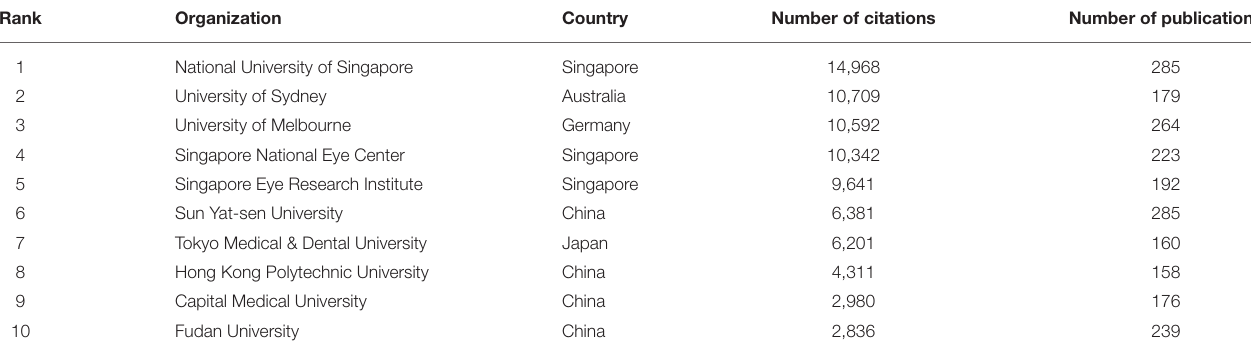
TABLE 4 | Top 10 influential organizations for myopia studies.